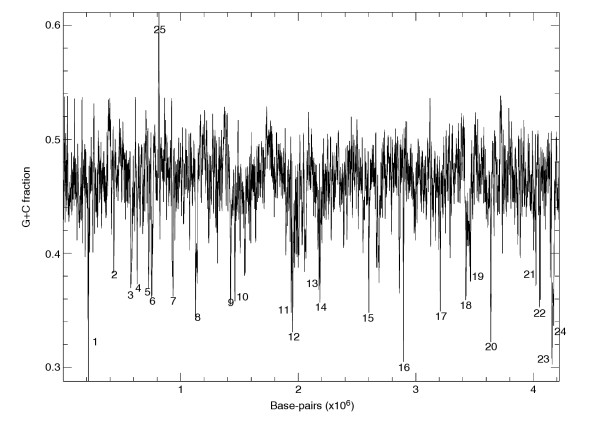
Isochore plot of the B. licheniformis ATCC 14580 genome showing G+C content as a function of position. AT-rich peaks (numbered 1-24) are marked on the plot, and a single island that is atypically GC-rich is indicated by number 25. Table 2 lists the specific chromosomal features represented by each numbered peak.